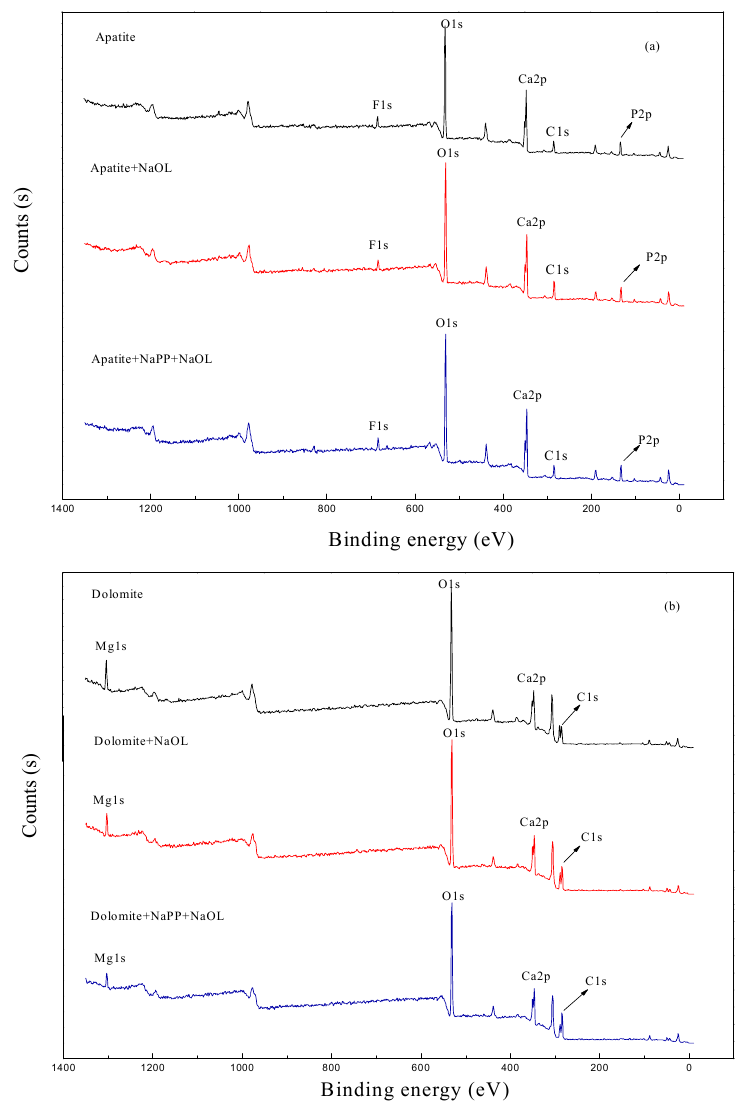
Figure 8. Broad scan XPS spectra of ( a ) apatite and ( b ) dolomite before and after treatment with NaPP or NaPP + NaOL. Table 2. Binding energy of elements on the minerals surface under different reagent conditions.